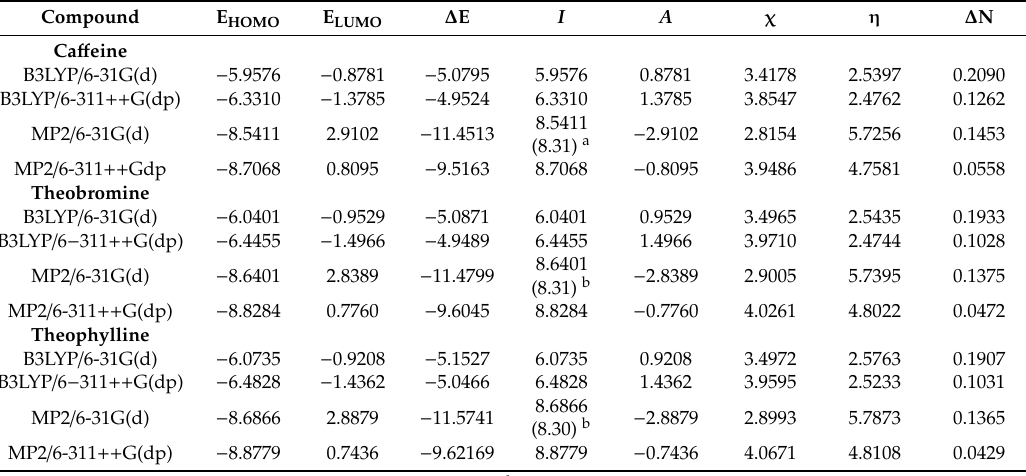
Table2. Thecalculatedquantumchemicalparametersofneutralca ff eine, theobromine, andtheophylline in the gas phase at a di ff erent level of theory. (All values are in eV). Compound E HOMO E LUMO